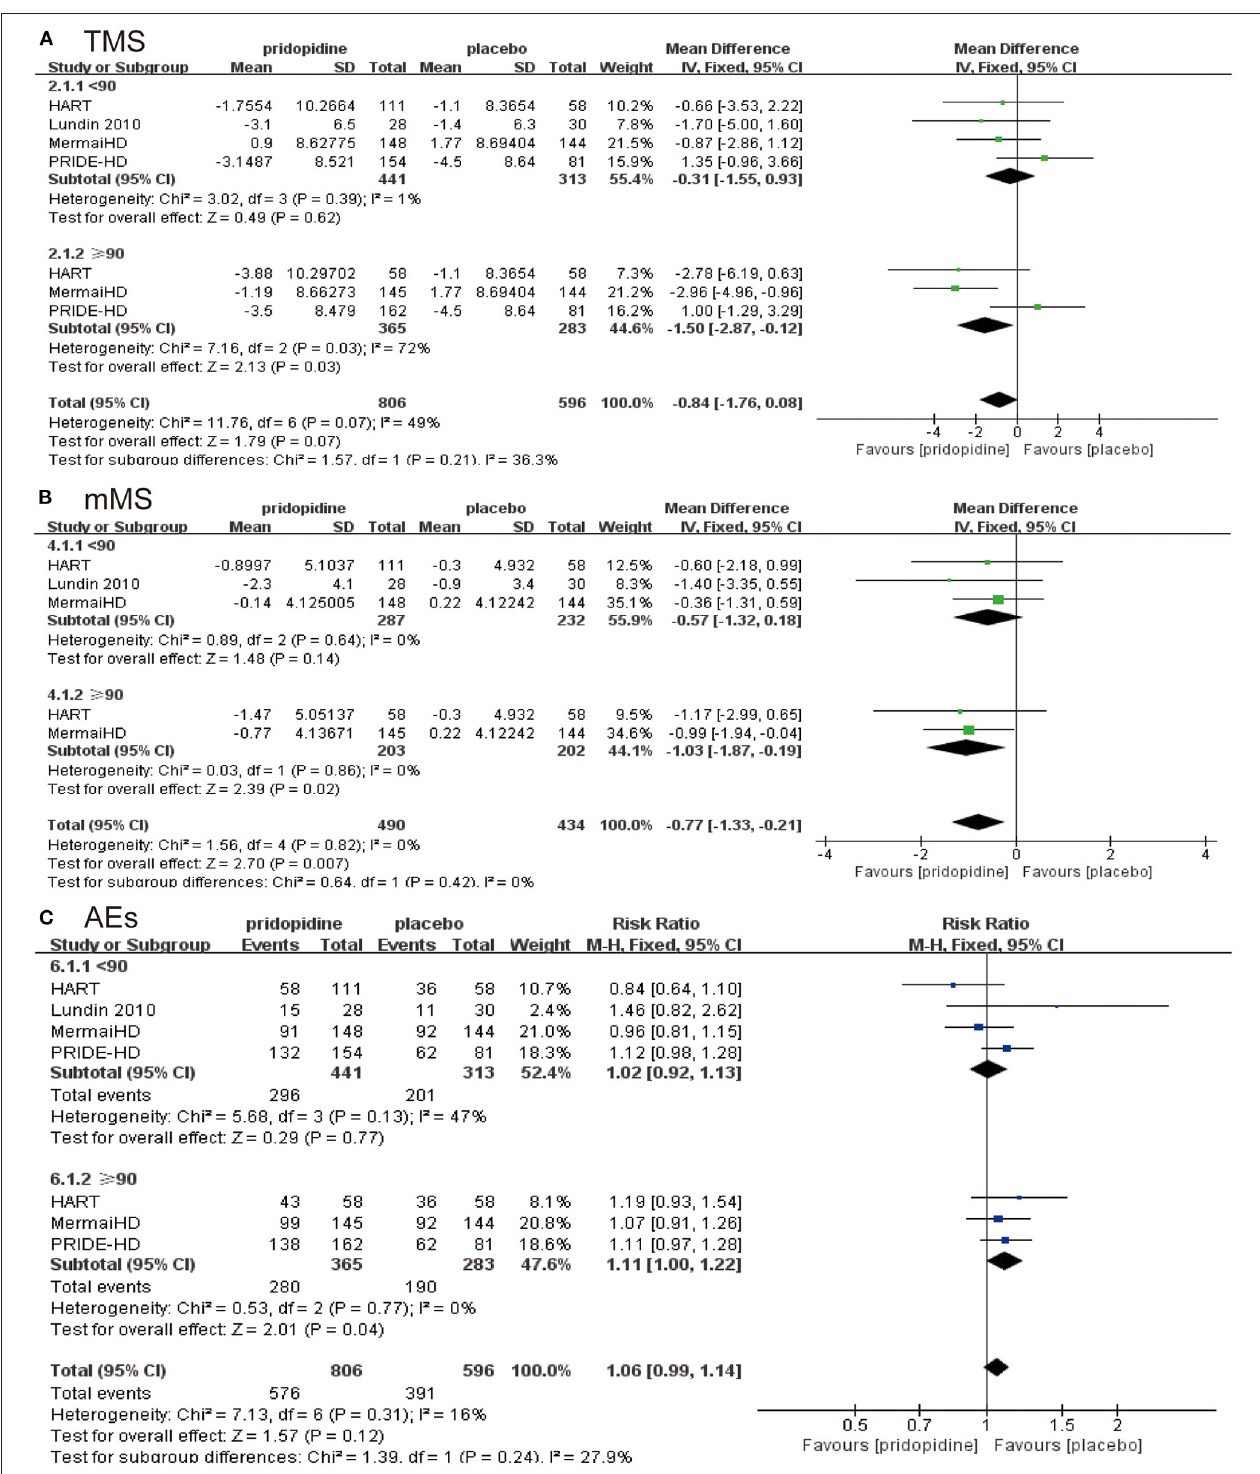
FIGURE 4 | Subgroup analysis of different dosages of pridopidine ( < 90 mg/day/ ≥ 90 mg/day) on efficacy and safety outcomes. The blue diamond indicates the estimated risk ratio (95% confidence interval), and the green diamond indicates the mean difference (95% confidence interval) for all patients together. (A) TMS. (B) mMS. (C) adverse